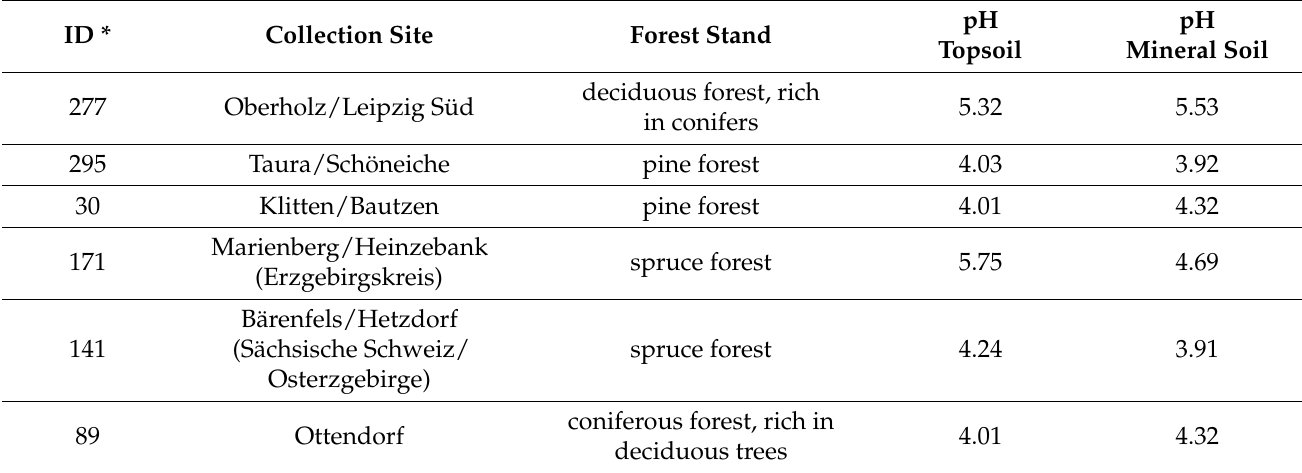
Table 2. List of the soil collected from different locations in Saxony,